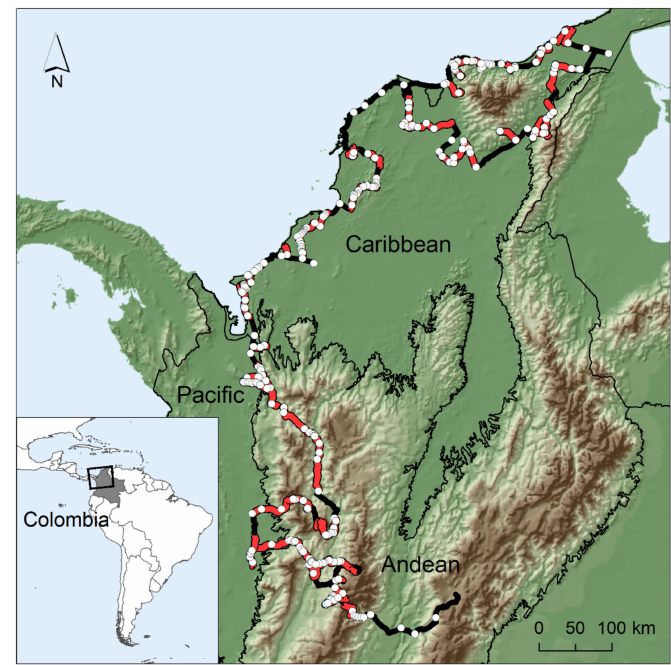
Figure 1. Study area showing the itinerary (black line) crossing the Andean, Pacific and Caribbean regions of Colombia, the roadside parrot surveys (in red), and the localities where poached pets were recorded (white